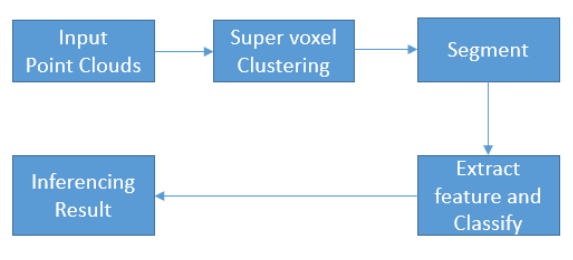
Figure 1. The overview of the classification method framework